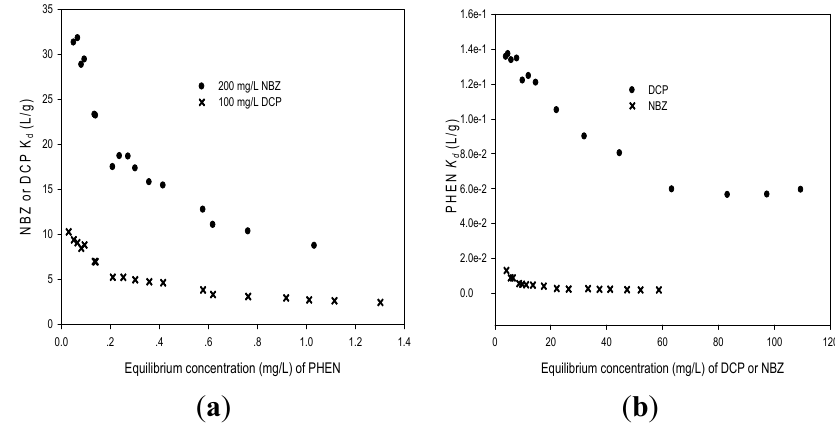
Figure 4. Competition between PHEN and neutral DCP and NBZ on HBPMS: ( a ) K d of 200 mg/L NBZ or 100 mg/L DCP as a function of equilibrium PHEN concentration; ( b ) K d of 10 mg/L PHEN as a function of equilibrium DCP or NBZ concentration.